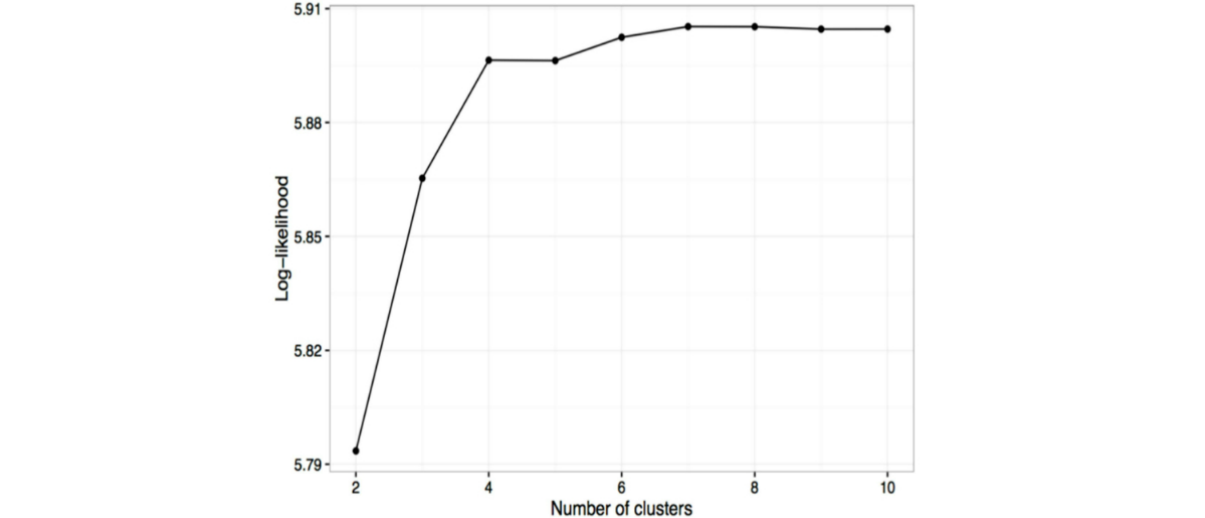
Figure 3. Plot of the log-likelihood of different numbers of clusters in hidden Markov sequences; the elbow indicates the optimal number of clusters which should be